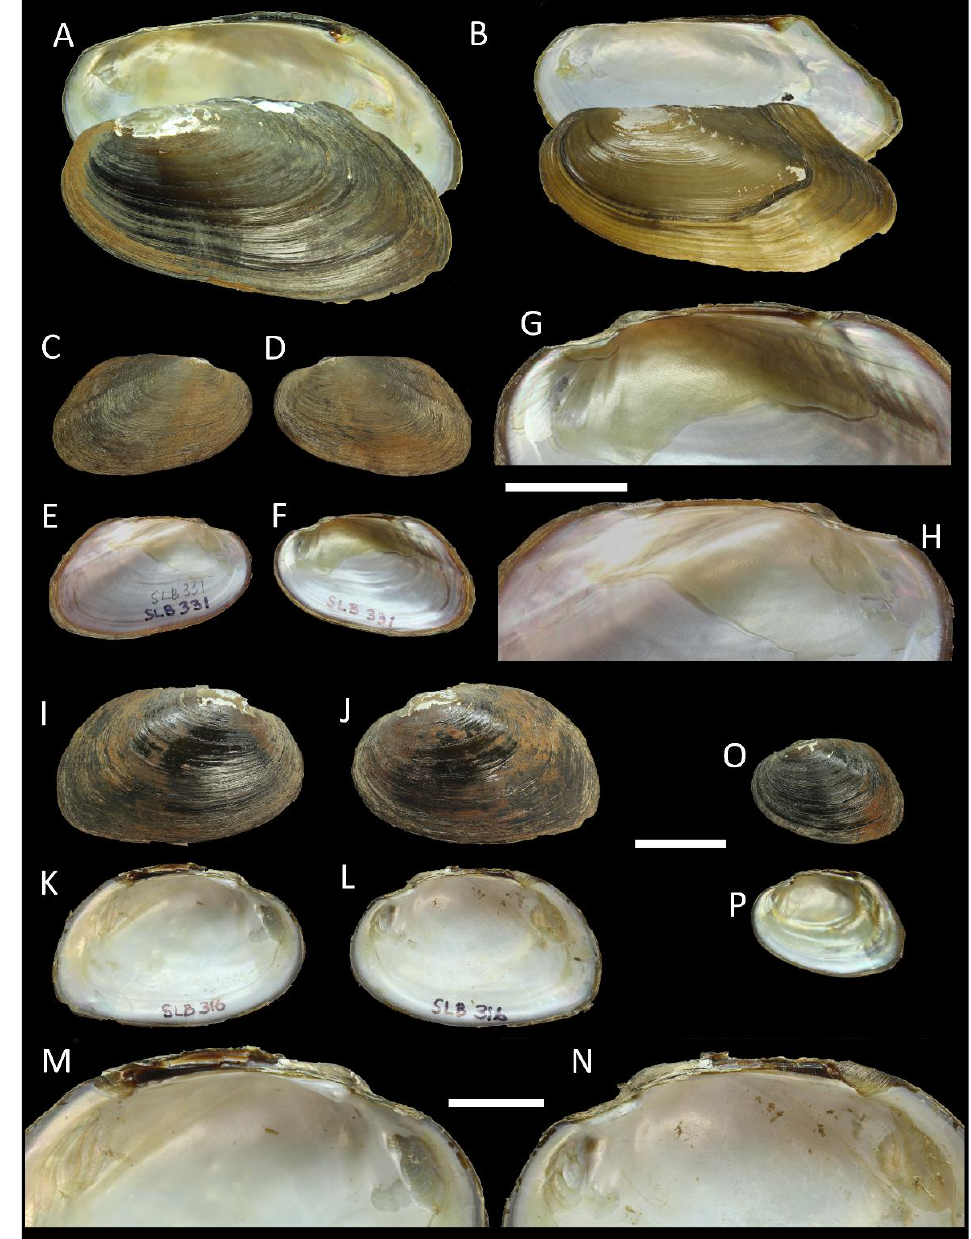
Figure 2. Shells of Pilsbryoconcha , Songkhlanaia, and Sundadontina from Southern Thailand. ( A ) P. compressa (Martens, 1860), RMBH biv 1310/1, Klong Nong Thung Tong, Surat Thani Province; ( B ) Pilsbryoconcha schomburgki (Martens, 1860) stat. rev. , specimen RMBH biv 1284/1, Old main Tapi River, Surat Thani Province; ( C – H ) Songkhlanaia tamodienica gen. & sp. nov. , holotype RMBH biv 1332, Klong Plug Pom, Phatthalung Province: right ( C ) and left ( D ) valve view, inside view of left ( E ) and right ( F ) valve, interior view zoom fragment of right ( G ) and left ( H ) valve; ( I – N ) Sundadontina plugpomenica sp. nov. , holotype RMBH biv 1324/1, Klong Pa-Payom, Phatthalung Province: right ( I ) and left ( J ) valve view, inside view of left ( K ) and right ( L ) valve, interior view zoom fragment of left ( M ) and right ( N ) valve; ( O , P ) S. plugpomenica sp. nov. , specimen RMBH biv 1331, Klong Plug Pom, Phatthalung Province: ( O ) left valve view, ( P ) inside view of right valve. Scale bar = 20 mm ( A – F , I – L , O , P ); scale bar = 10 mm ( G , H , M , N ). Photos: Ekaterina S.